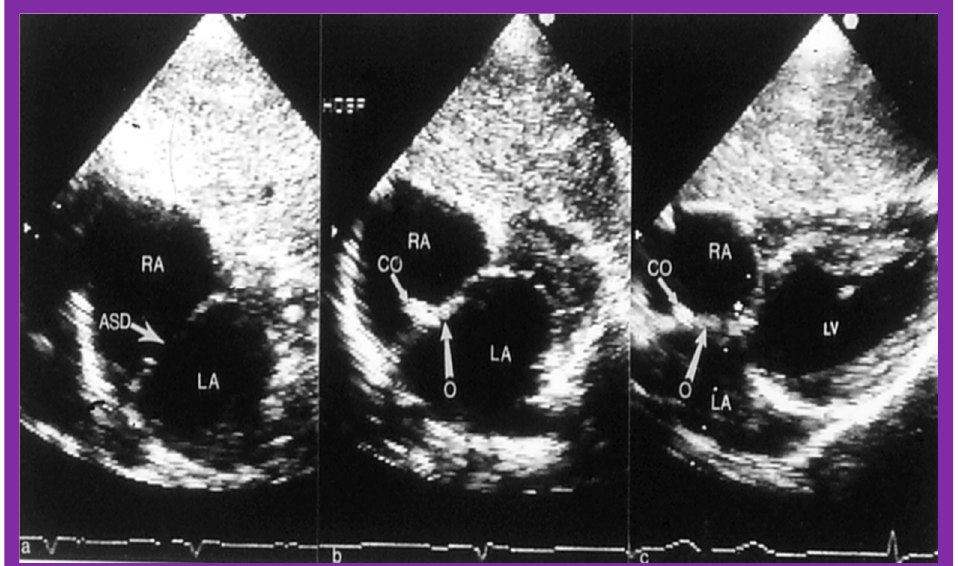
Figure 40. Echocardiographic images from subcostal projections of an atrial septal defect (ASD) (arrow in ( a )) before occlusion ( a ) with a buttoned device and several hours ( b ) and three months ( c ) following device deployment. The big arrows in both ( b ) and ( c ) identify the occluder component (O) on the left-atrial (LA) side of the atrial septum and the small arrows points out the counter- occluder (Co) on end on the right-atrial (RA) side of the atrial septum. LV, left ventricle. Replicated from Reference [26].